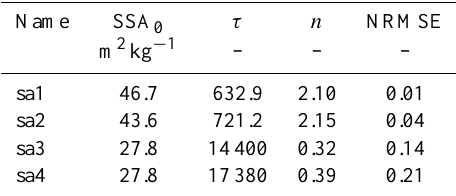
Table 2. Values of the fitted growth rate τ and growth exponent n for the evolution of the SSA and the corresponding normalized root mean square error (NRMSE).